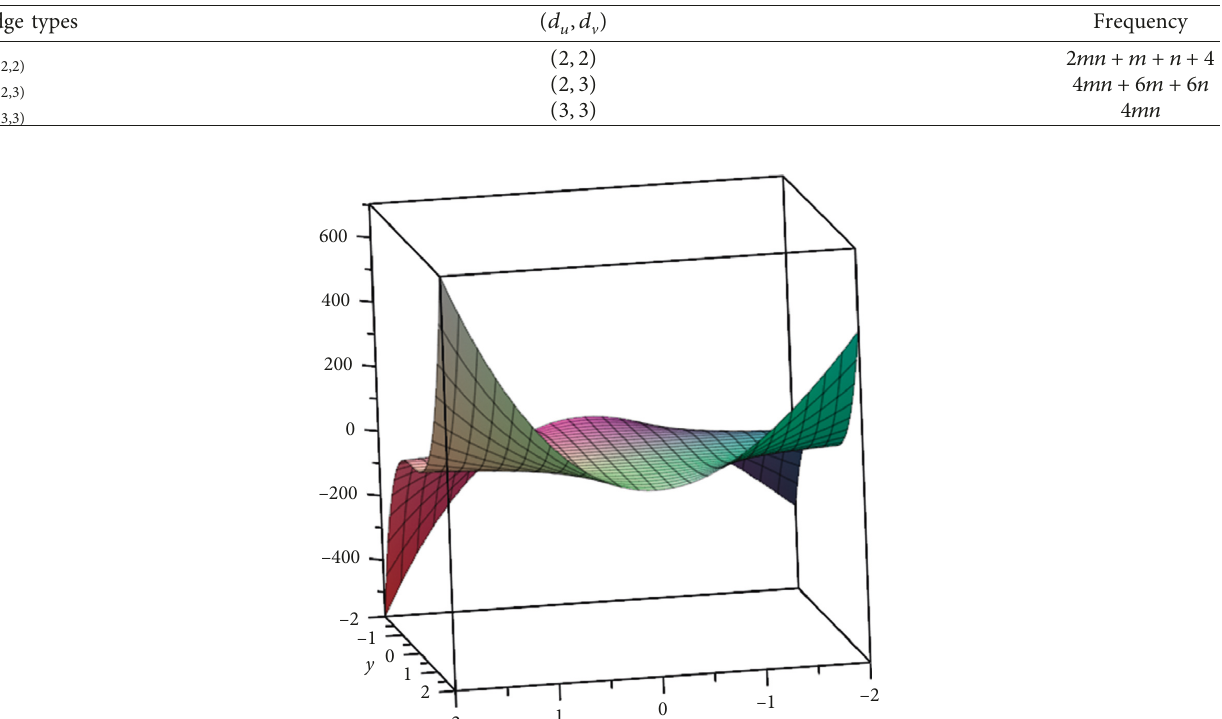
Figure 3: Graph of octa-graphdine nanosheet O Table 3: Edge Partition of O